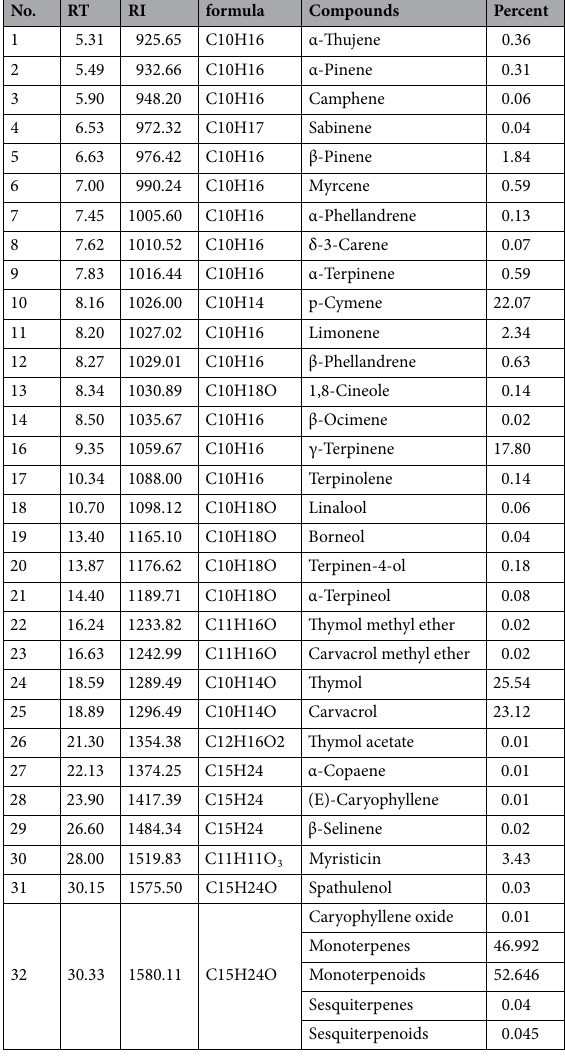
Table 1. Chemical compositions of Oliveria decumbens essential oil (OEO) identified by gas chromatography and gas chromatography-mass spectrometry. Retention indices were determined using retention times of n-alkanes as standard on fused silica capillary HP-5 column that was injected after essential oil under the same chromatographic conditions.